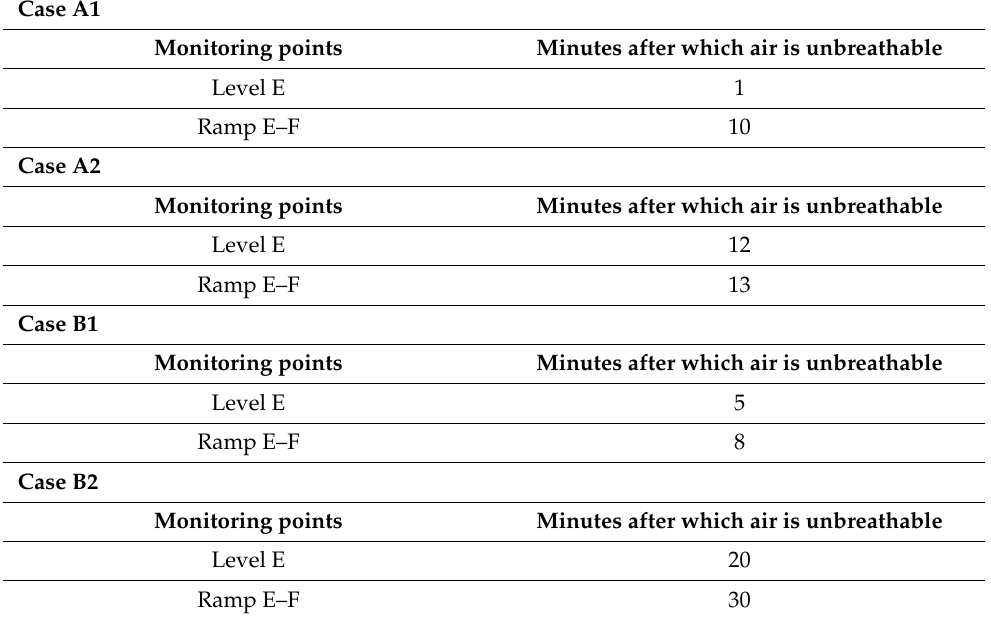
Table 2. Minutes beyond which the air becomes unbreathable due to the fire fumes in two different critical points of the mine, which are at Level E and on the ramp E–F, which connects Levels E and